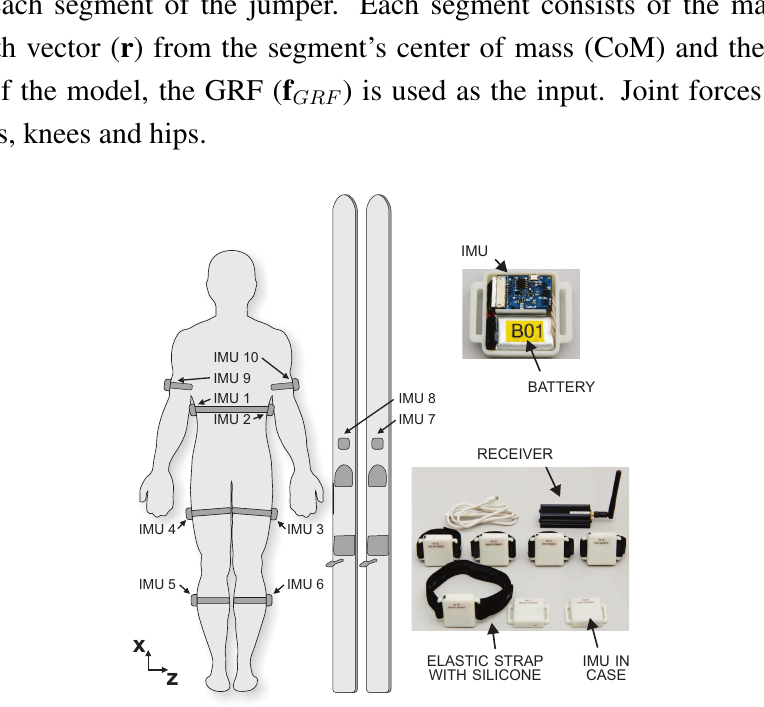
Figure 1. Wearable measurement system composed of 10 inertial measurement units and the setup for positioning the units on the jumper.